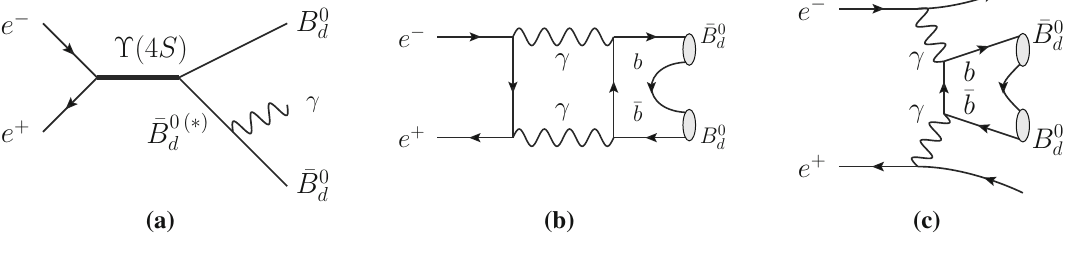
Fig. 5 Potential background contributions to the ω effect observables (28), (29) are also sensitive to Re (ω) , but they do not show any significant deviation from Re (ω) = 0, and in this sense they are inferior to the previous analyses [21] using equal sign semileptonic decay asymmetries of the B system, which yield Re (ω) = ( 0 . 8 ± 4 . 6 ) × 10 − 3 . The results (26) and (27) also allow a fit to the CPT violating parameter θ , and they are compatible with the previous determination in [8] and the one performed by the BaBar collaboration in [29], pointing towards a 2 σ effect in Re (θ) , also interpreted as an upper bound for the corresponding